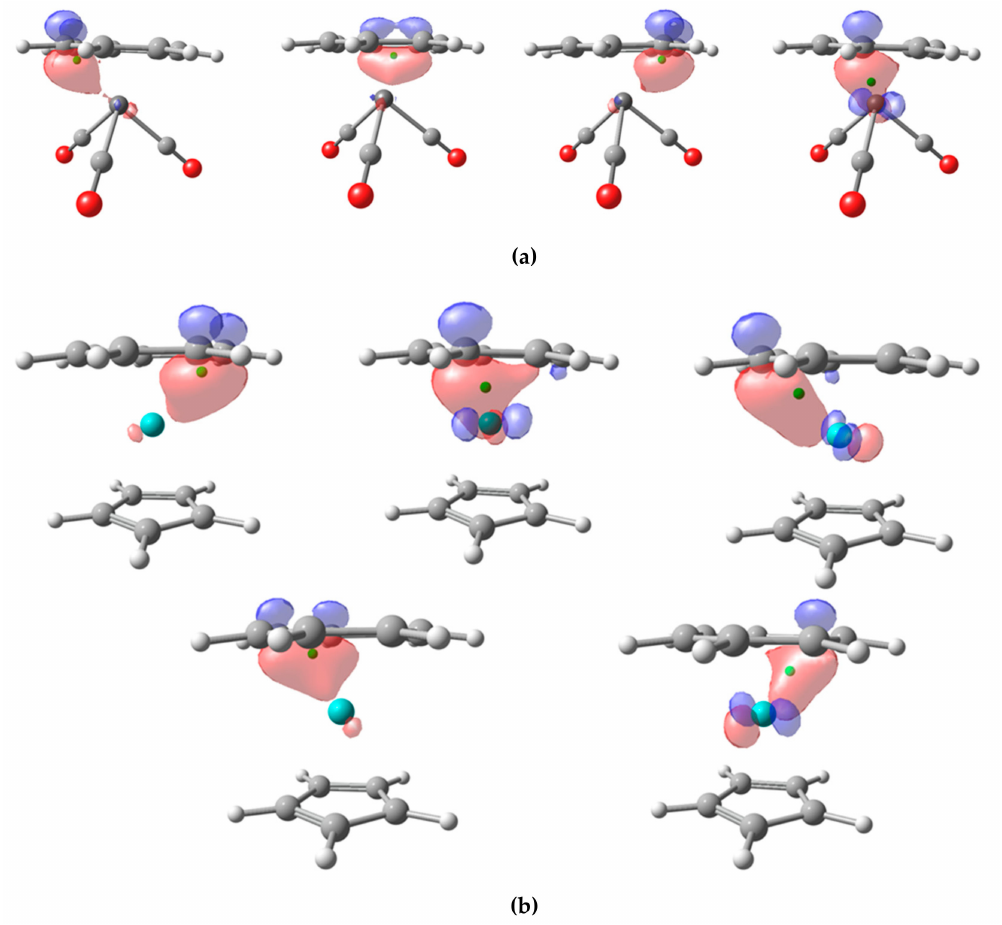
Figure 6. Isocontour plot (0.1) of NLMO localized on the C 7 H 7 π -ligand for V(CO) 3 (C 7 H 7 ) ( a ) and Mo(C 7 H 7 )(C 5 H 5 ) ( b ). Orbital centroid represented by green